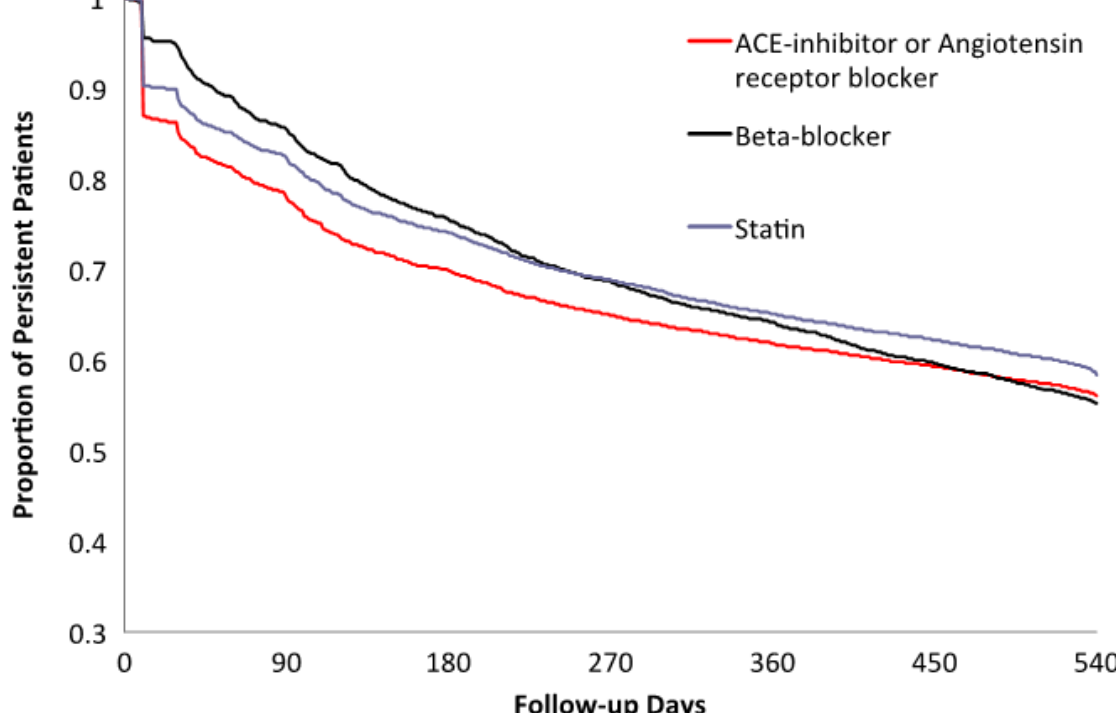
Figure 1. Persistence with secondary prevention medications after angiography. ACE: angiotensin-converting